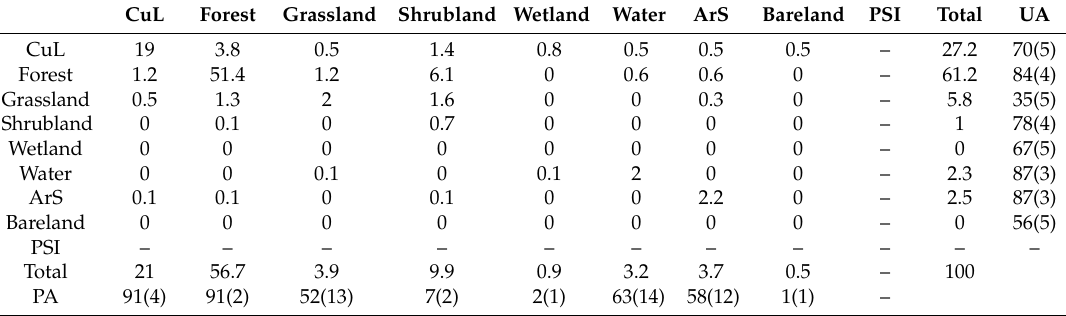
Table A6. The error matrix of estimated area proportions for R6: Overall accuracy is 77.4%